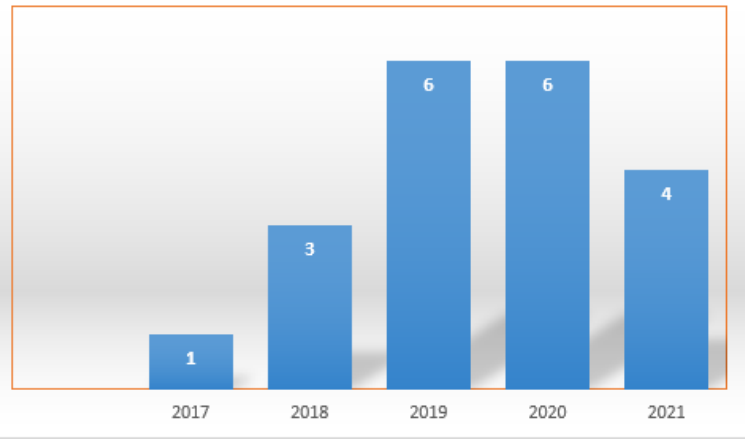
Figure 5. Date of publication.